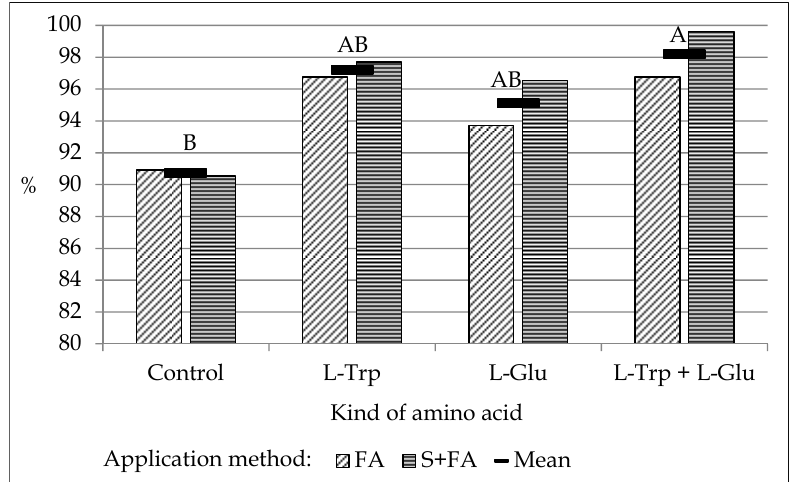
Figure 2. The proportion of marketable yield of storage roots in total yield in response to treatment combinations, on average across two years (2019–2020); FA—foliar application, S + FA—soil and foliar application, L ‐ Trp—L ‐ tryptophan, L ‐ Glu—L ‐ glutamic acid; and means (n = 3) followed by different letters in differ significantly at p ≤ 0.05.